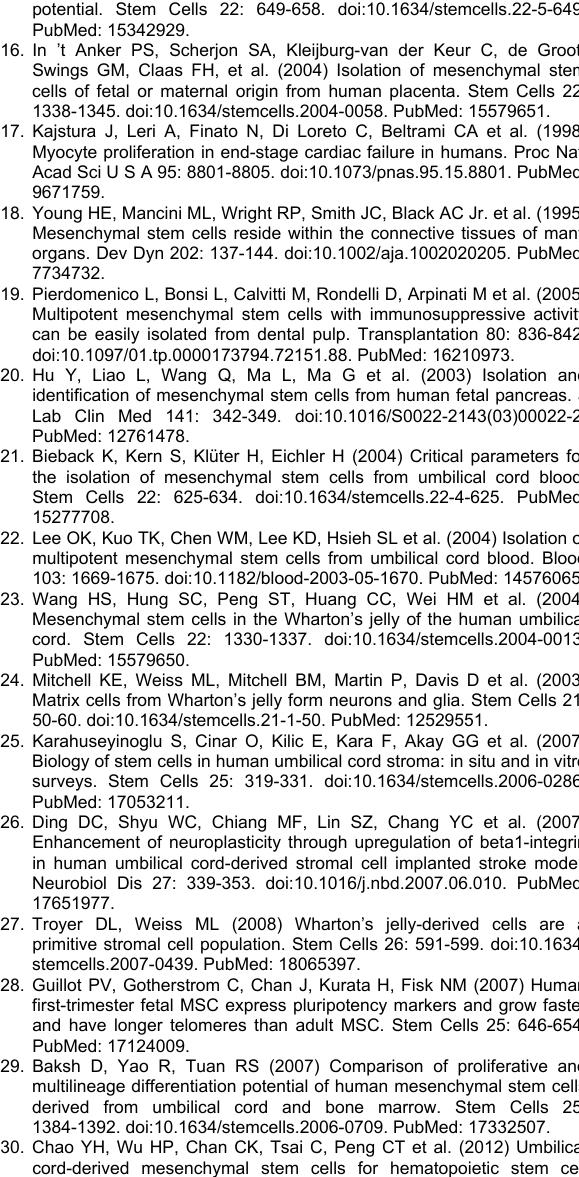
Table S1. The sequences for the primers of RT- PCR. (DOCX) Table S2. Comparison of surface markers in mouse and human-derived MSCs. (DOCX)